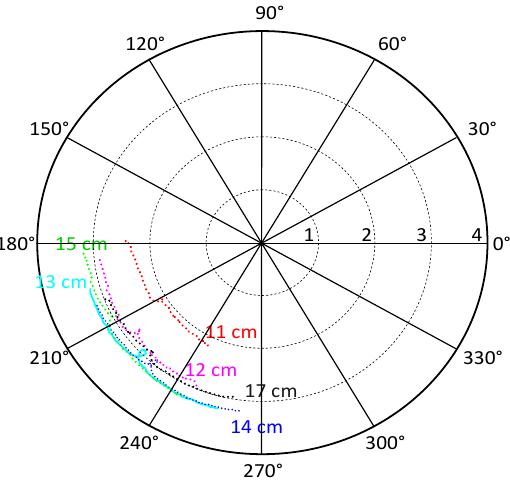
Figure 6. Fitted signals in presence of bitumen for different lengths of the transponder